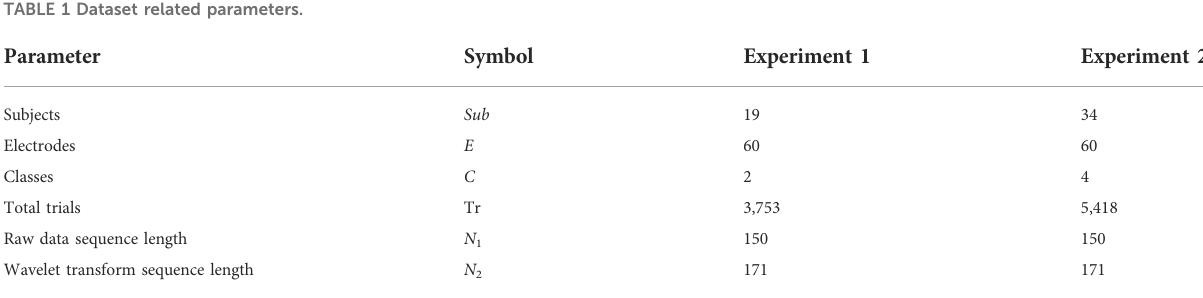
TABLE 1 Dataset related